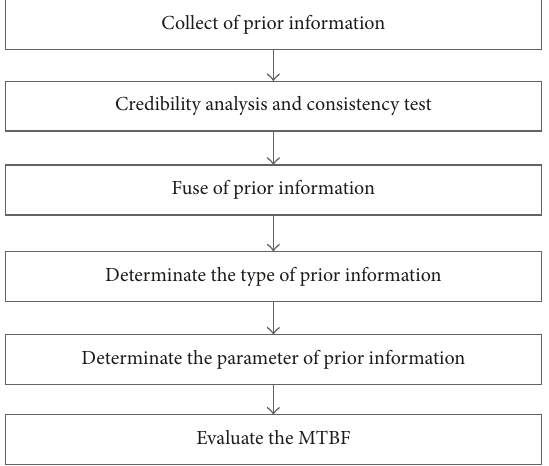
Figure 1: Reliability evaluation step of low-voltage switchgear.